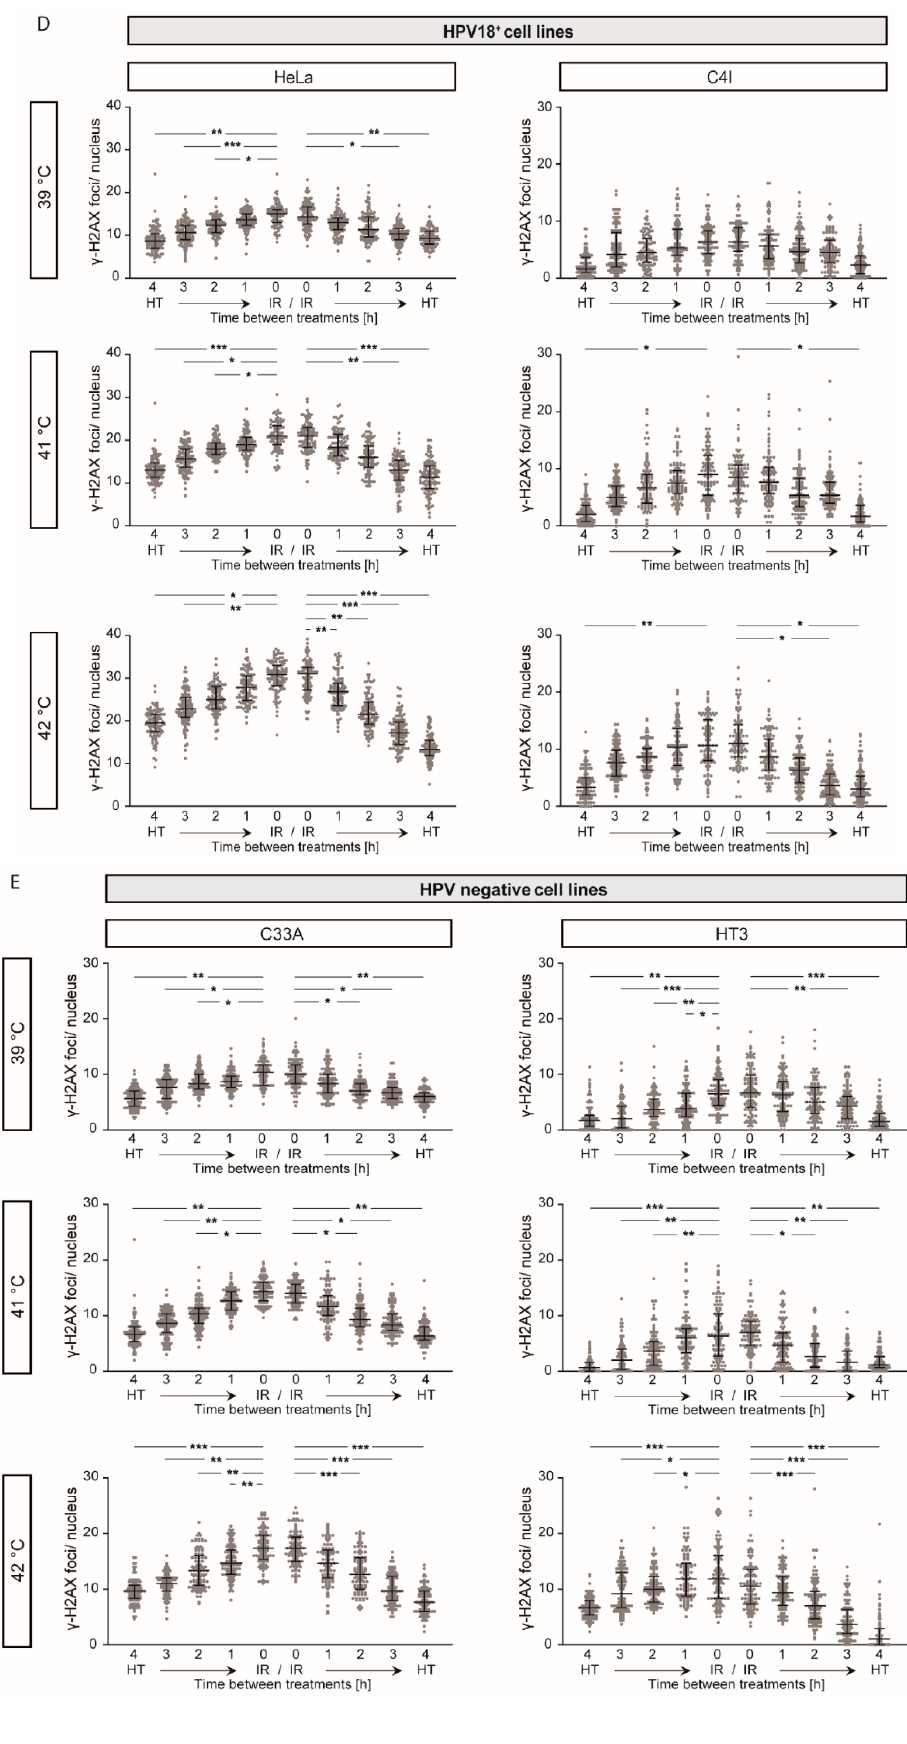
Figure 4. Higher levels of DNA damage were observed after treatment with a shorter time interval between ionizing radiation and hyperthermia. ( A ) Cells in S-phase were excluded to only count the γ -H2AX positive double strand breaks (DSBs) that were radiation-induced. ( B ) SiHa cells demonstrating the DNA damage using γ -H2AX foci—cells were fixed 24 h after treatments. ( C–E ) γ - H2AX foci of HPV16 + , HPV18 + , and HPV-negative cell lines between ionizing radiation (IR; 2 Gy) and hyperthermia (HT) after treatments with different time intervals, different sequences, and various temperatures. Means with standard deviation of at least three replicates are presented, with a minimum of 100 cells per replicate. * p < 0.05, ** p < 0.01, and *** p < 0.001 indicate the difference between 0 and 1, 2, 3, and 4 h time interval between ionizing radiation and hyperthermia, or the opposite order of treatments. 3. Discussion The results of the present in vitro study demonstrated that the sequence of ionizing radiation and hyperthermia makes no major difference in terms of radiosensitization, since both sequences induced similar amounts of cell survival, similar changes in cell cycle distributions, similar levels of remaining DNA breaks, and similar changes in apoptotic levels (Figure 5). In our previous publication, we have already demonstrated the additional effect of adding hyperthermia to ionizing radiation [26]. In this study, we focused on the effect of time intervals between, and sequences of hyperthermia and ionizing radiation on, DNA damage and cell survival. However, according to a retrospective study on cervical cancer patients, it is of clinical relevance to keep the time interval as short as possible between hyperthermia and ionizing radiation to increase tumor cell kill, which may be pivotal in tumor control and patient cure [27]. This significant effect of shorter intervals can be explained by an increase of cells with unrepaired DNA damage, resulting in more apoptosis. Cell cycle check-points prevent cells from being replicated or divided if DNA is damaged, by prolonging cell cycle phases. There were only slight changes in the cell cycle distribution, which can indicate the presence of DNA damage, but this was cell line dependent. In all six cervical cancer